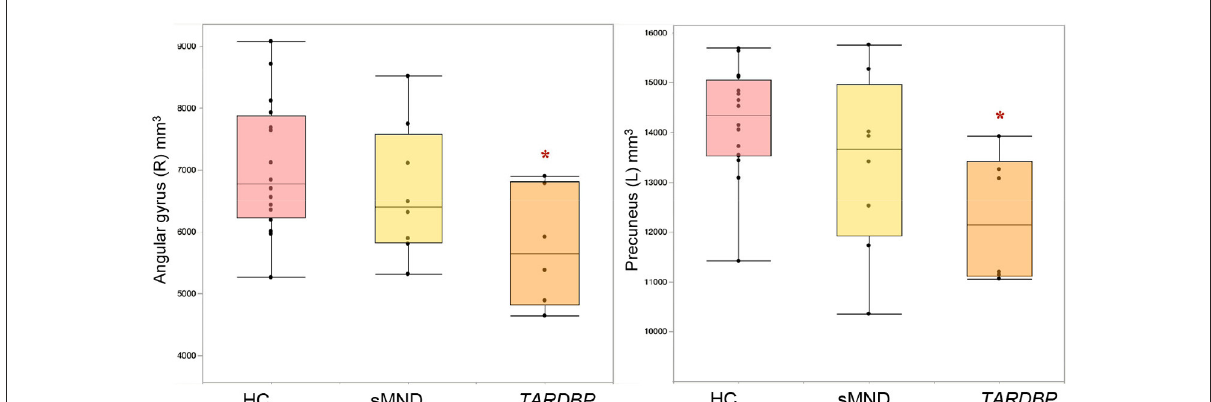
FIGURE2 Gray matter (GM) cortical volumes showing significant differences in MND patients and controls. Values refer to mm 3 . Comparisons between groups were performed using age-, sex-, and MRI scanner-adjusted analysis of variance models, followed by post-hoc pairwise comparisons, Bonferroni-corrected for multiple comparisons. HC, healthy controls; L, left; R, right; sMND, sporadic motor neuron disease. * Significantly different from HC.